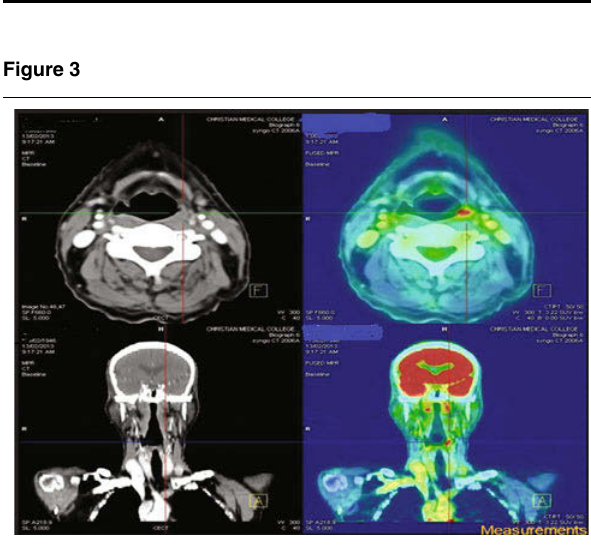
Abnormal 18 FDG uptake [standardized uptake value (SUV) = upto 3.70] is noted in the nasopharynx with mild